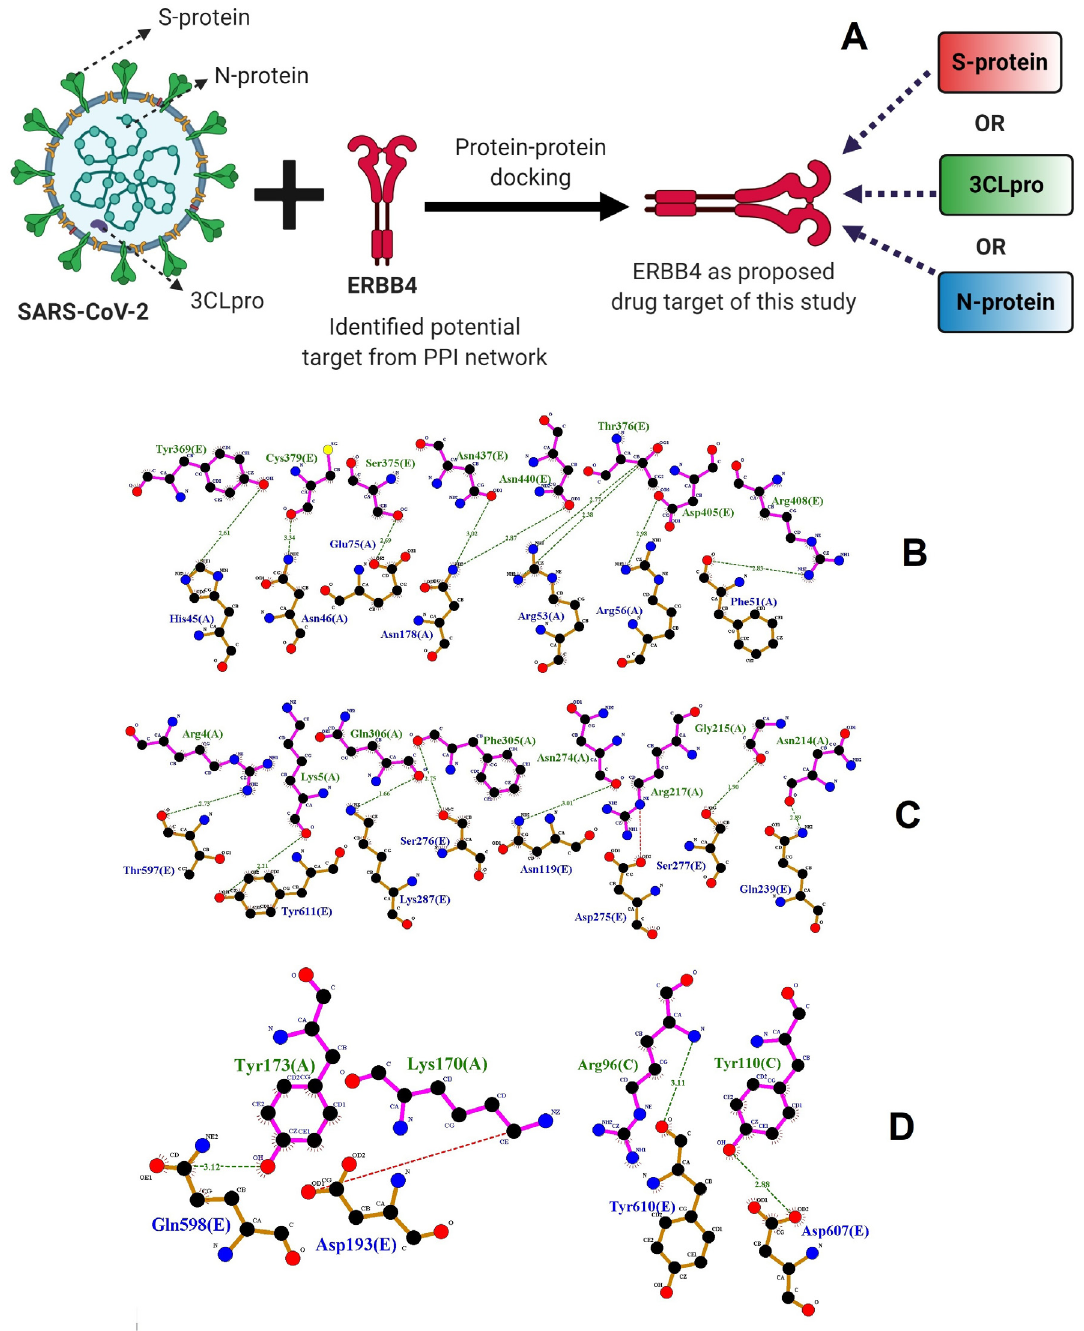
Figure 6. Possible action and PPD of drug target ERBB4 with SARS-CoV-2 proteins. ( A ) Possible pathological action of SRBD, 3cLpro, and N-protein of SARS-CoV-2 with “ERBB4”. Results of PPD of ( B ) ERBB4-SRBD; ( C ) ERBB4-3cLpro; and ( D ) ERBB4-N-protein complex by using LigPlot. The interacting residues of ERBB4 (magenta) are labelled in green color and SARS-CoV-2 protein structures (brown) are labelled in blue color. The interacting hydrogen bonds indicated in green